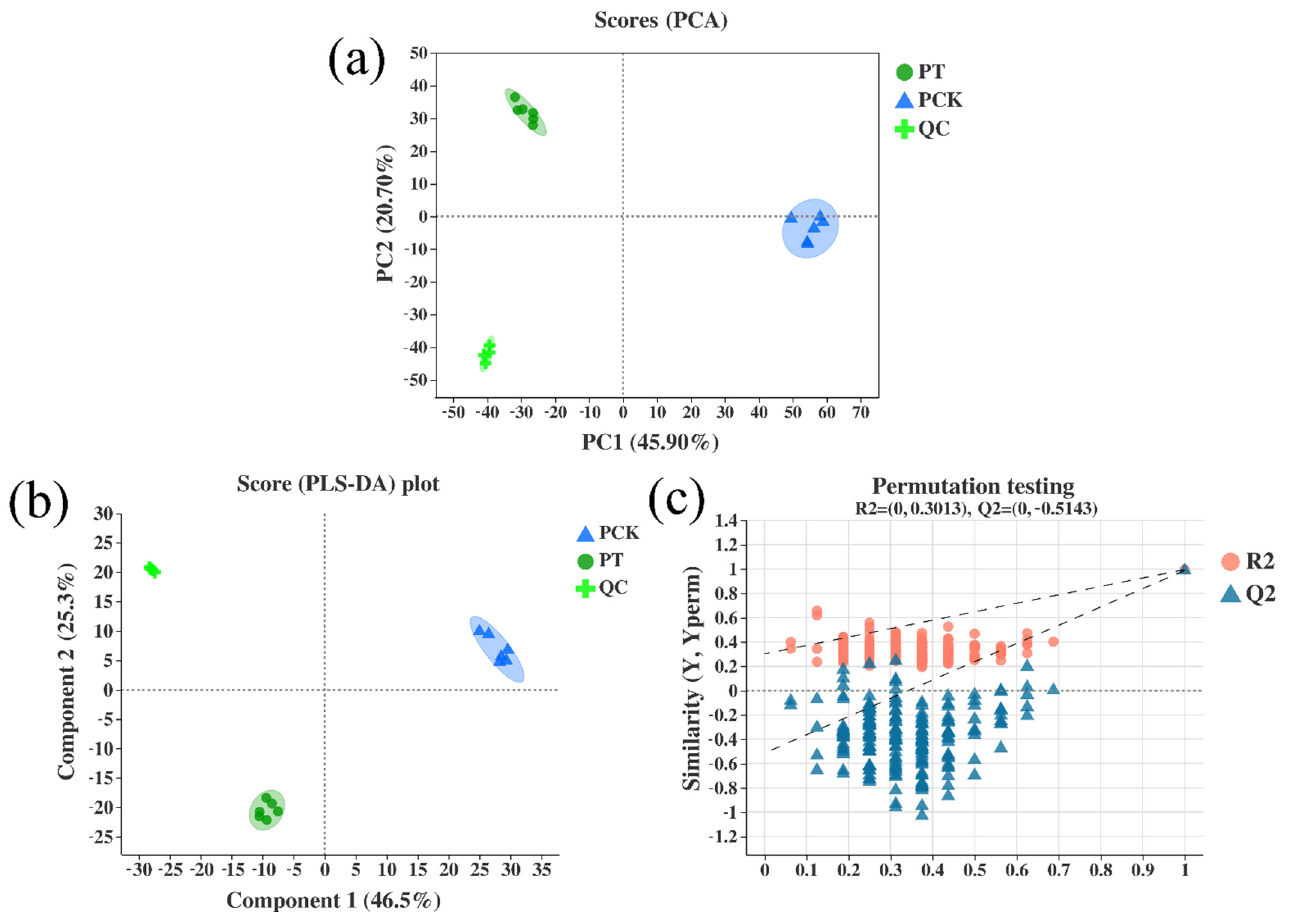
Figure 1. PCA score plots of treated and untreated P. palleroniana samples and QC samples ( a ). Validation of PLS-DA models of pairwise comparison among treated and untreated P. palleroniana samples ( b , c ). Abbreviations: quality control, QC; untreated P. palleroniana , PCK; light-treated P. palleroniana , PT .